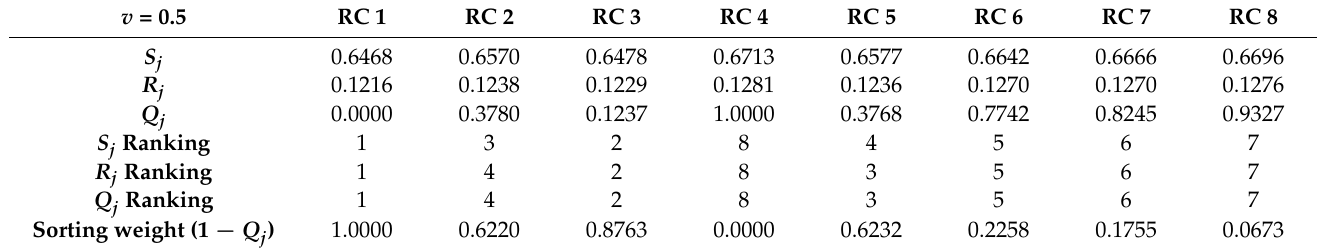
Table 13. Sorting results of